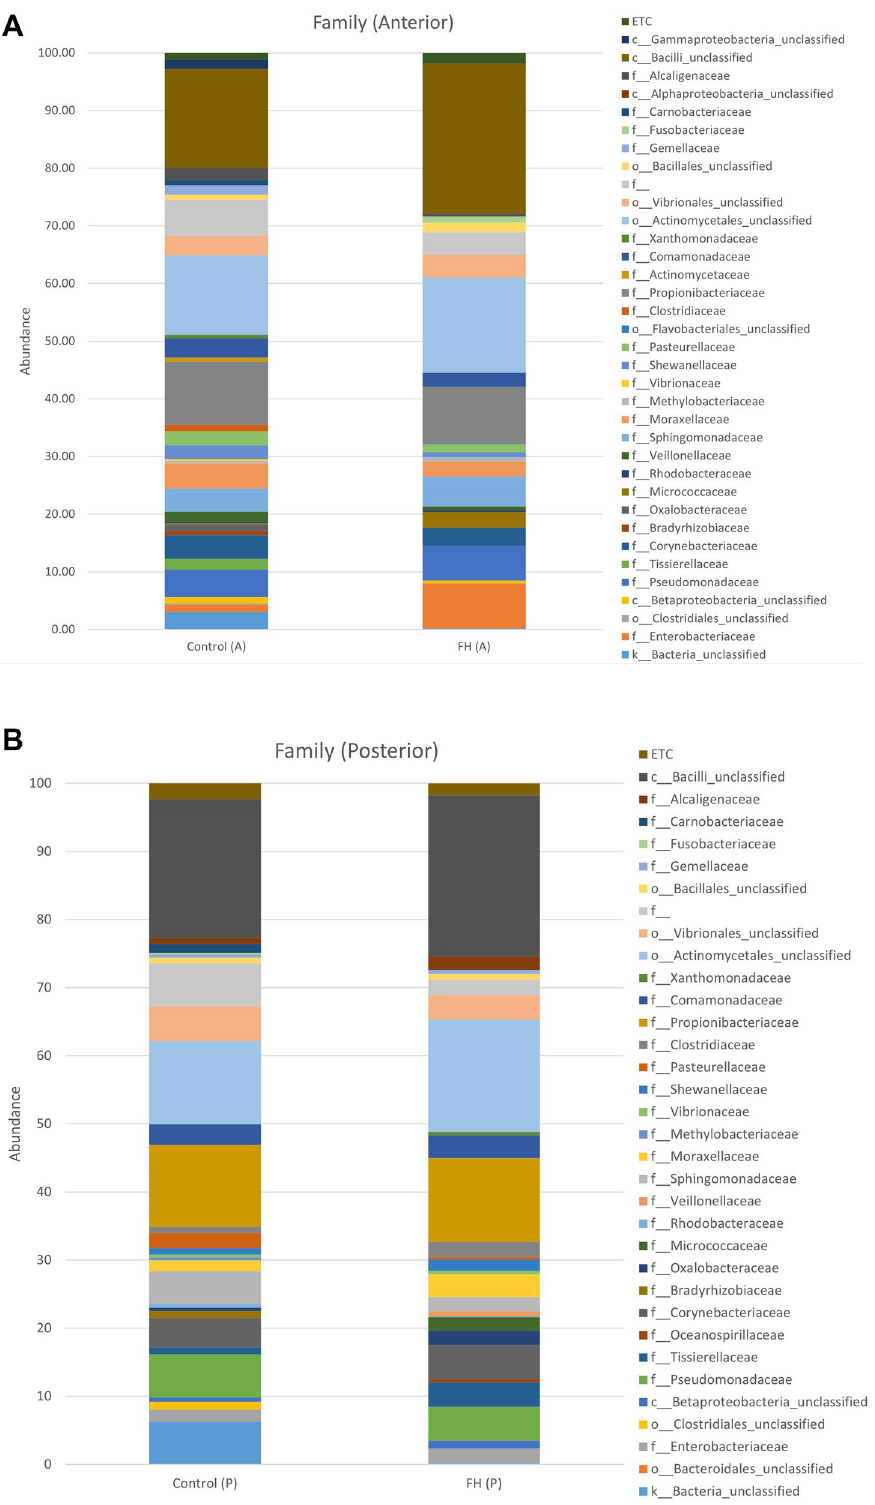
Figure 3. Average values of bacterial family groups obtained in the intestinal microbiota samples in anterior (A) and posterior (P) sections ( A , B , respectively) of S. aurata . Control (C-number) and N. gaditana hydrolyzed (FH-number) diets. ETC: families represented <